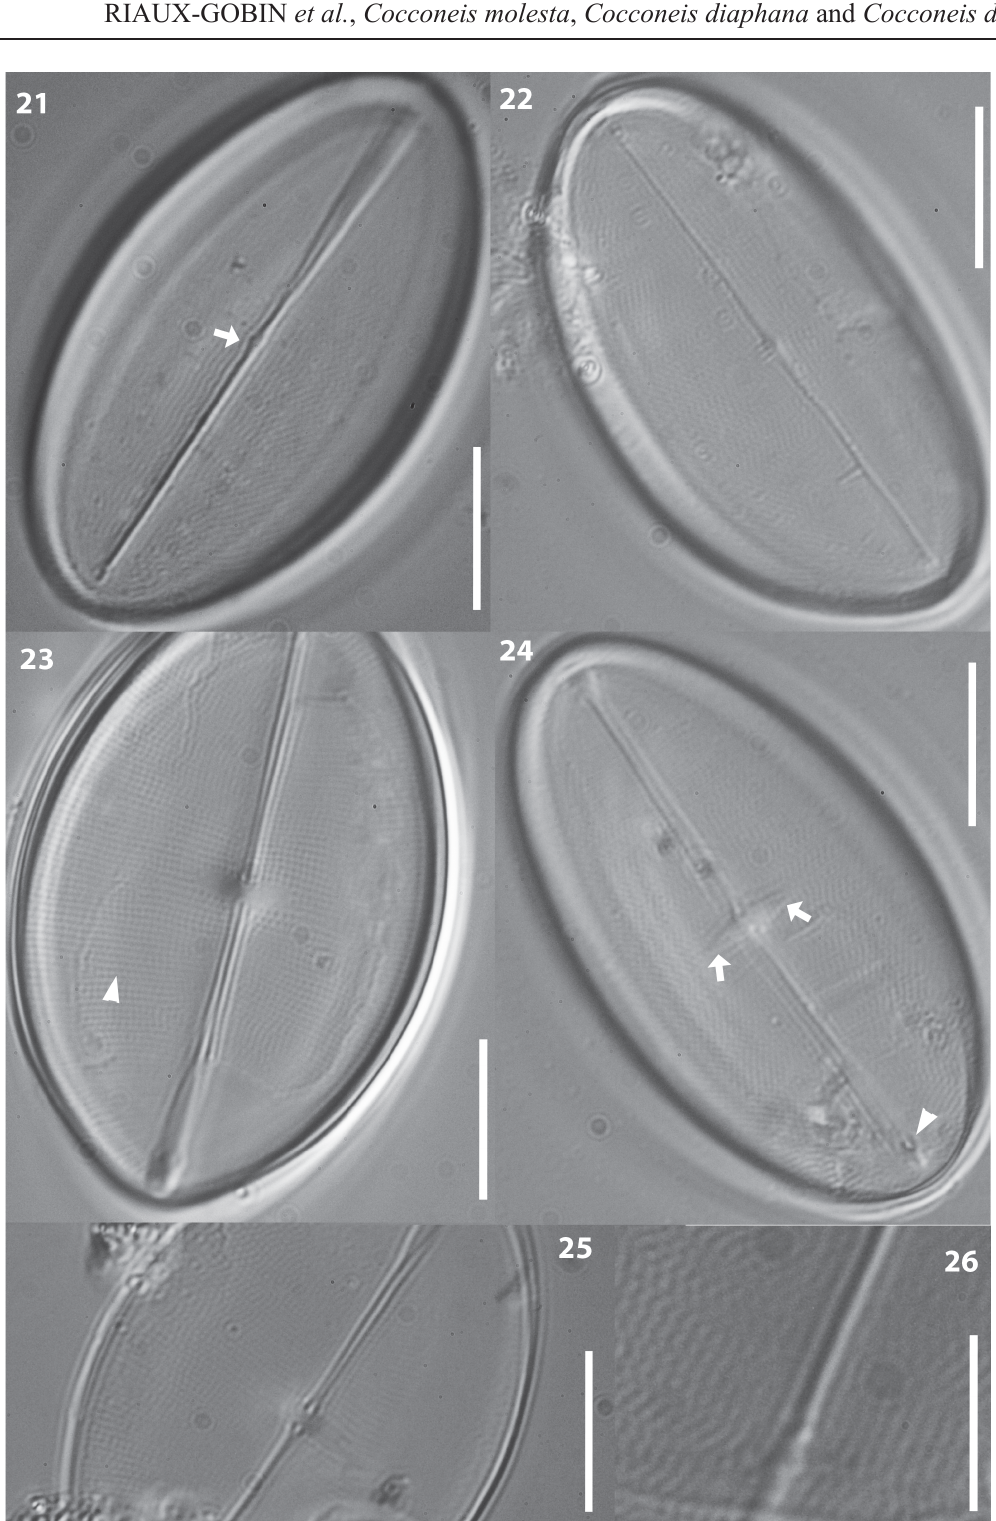
Figs 21–26. Cocconeis diaphana W.Sm. var. diaphana from BM 23161, “Jersey, Pontac”. 23 . Lectotype illustration. SV sternum narrow and straight (21–22), SV central area small (21, arrow), SV axial rows in a zig-zag pattern (21–22, 26). RV striation easily discernible and beaded (23, arrowhead), RV central area transapically enlarged but short (24, arrows), proximal raphe endings robust and close (25). Scale bars = 10 µm (21–25), 5 µm